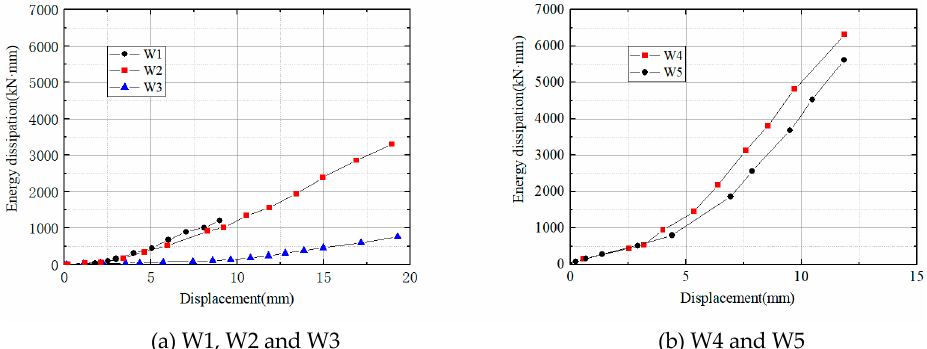
Figure 12. Energy dissipation per cycle for all test specimens: ( a ) W1, W2, and W3; ( b ) W4 and W5.